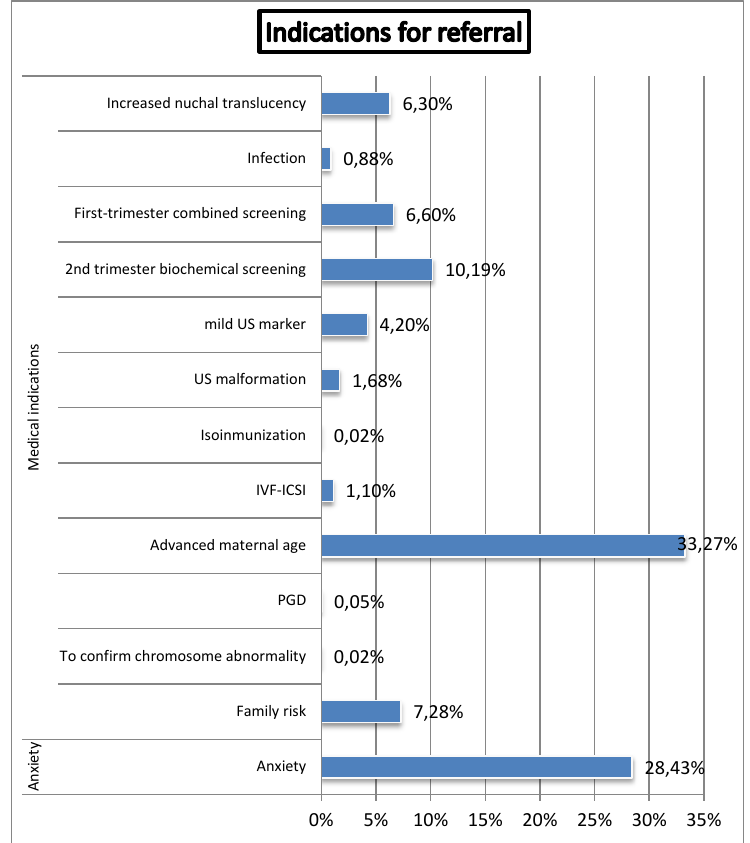
Figure 5. Distribution of indications for referral (IVF-ICSI: In Vitro Fertilization-Intra Cytoplasmic Sperm Injection. PGD: Pre-Implantation Genetic